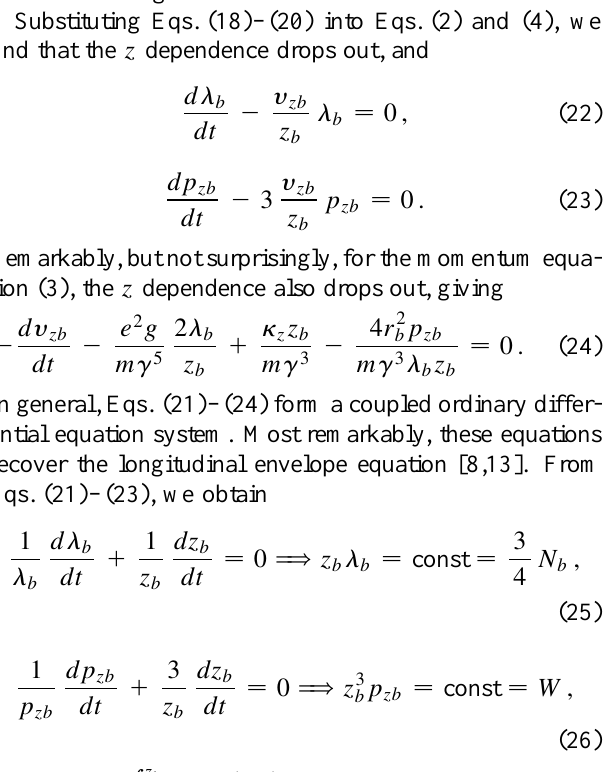
FIG. 2. The z dependences of field variables for the parabolic self-similar drift compression solution. The z dependences of l (cid:2) t , z (cid:3) , y z (cid:2) t , z (cid:3) , and p z (cid:2) t , z (cid:3) are illustrated in Fig.